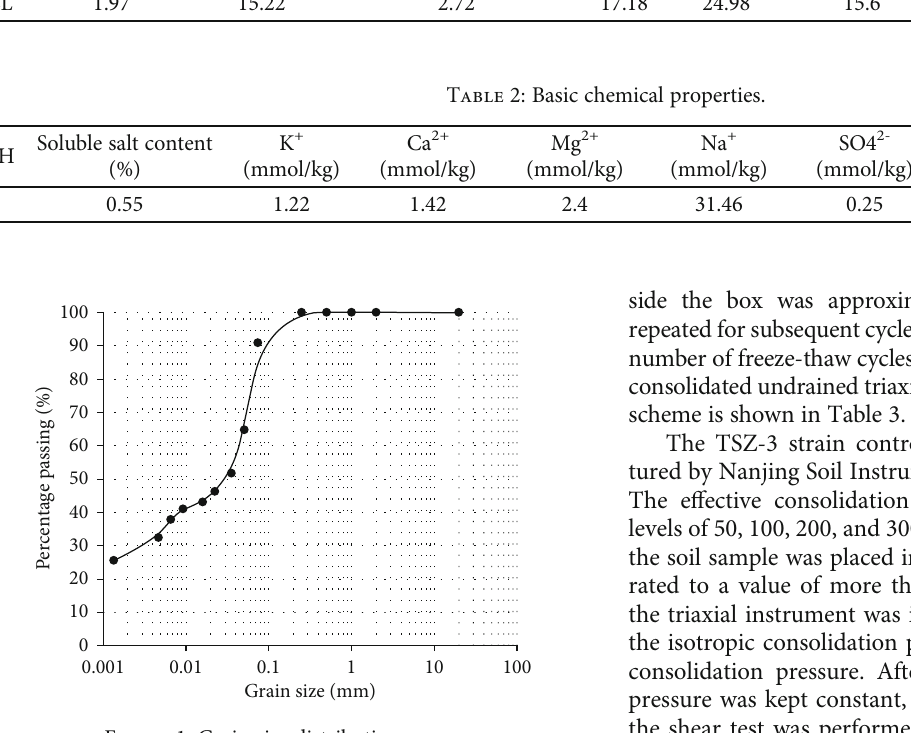
Figure 1: Grain size distribution